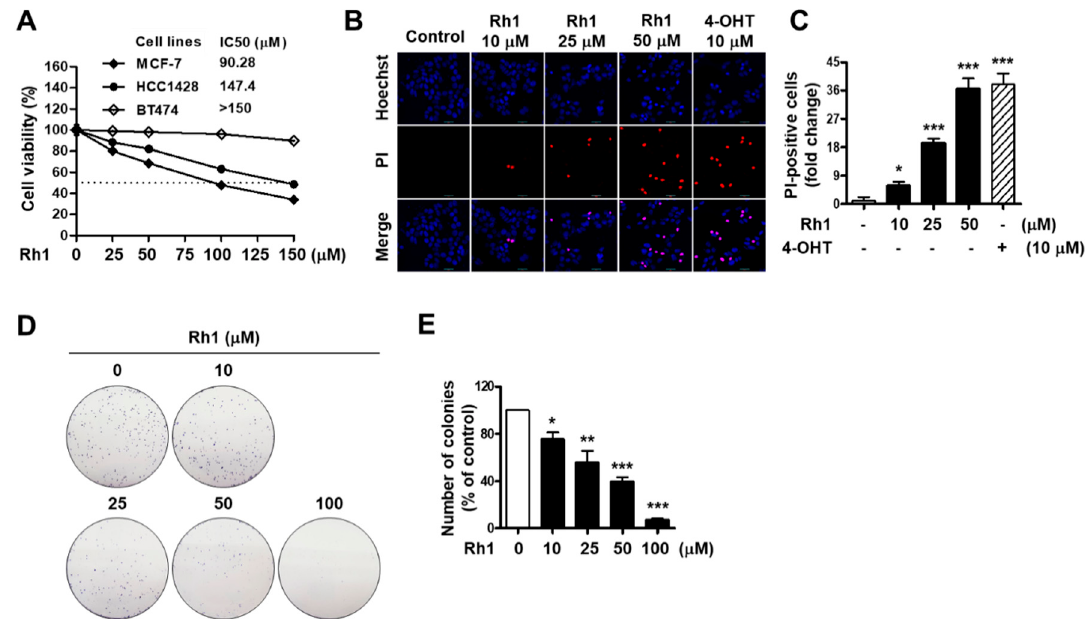
Figure 1. Anticancer effect of Rh1 on breast cancer (BC) cells. ( A ) MCF-7, HCC1428, and BT474 cells were treated with Rh1 (0, 25, 50, 100 and 150 µM) for 72 h. Cell viability was evaluated using the SRB assay. ( B , C ) MCF-7 cells were treated with Rh1 (10, 25, and 50 µM) or 4-OHT (10 µM) for 24 h. 4-OHT was used as a positive control. After the double staining with PI and Hoechst, the cells were observed under a fluorescent microscope, and the numbers of dead cells were quantified; a total of 5 fields per sample were counted. The cells stained with PI (red fluorescence) were indicated as dead cells. Images are shown at ×200 magnification. ( D , E ) Colony formation was assayed on a 6-well plate for 10 days, and then, the cells were fixed with 4% formaldehyde and stained with 0.5% crystal violet. Representative images, which are shown at ×1 magnification ( E ), and quantified bar graph ( F ) indicate the colony formation of MCF-7 cells. ( A , C , E ) Data are expressed as the mean ± SD ( n = 3 ), * p < 0.05, * * p < 0.01, and ** * p < 0.001 as compared with the control. 4-OHT: 4-hydroxytamoxifen, SRB: sulforhodamine B, PI: propidium iodide, and IC 50 : half-maximal inhibitory